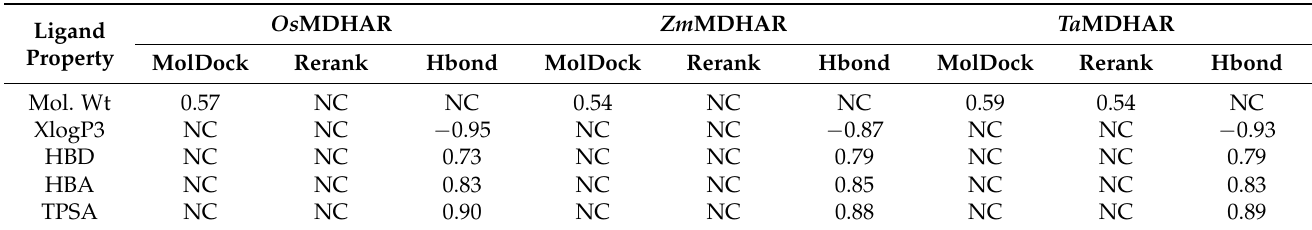
Table 5. Correlation analysis of docking scores (MolDock, Rerank and Hydrogen bond) of the MDHAR of rice, maize and wheat with different ligand properties. NC: Not correlated.